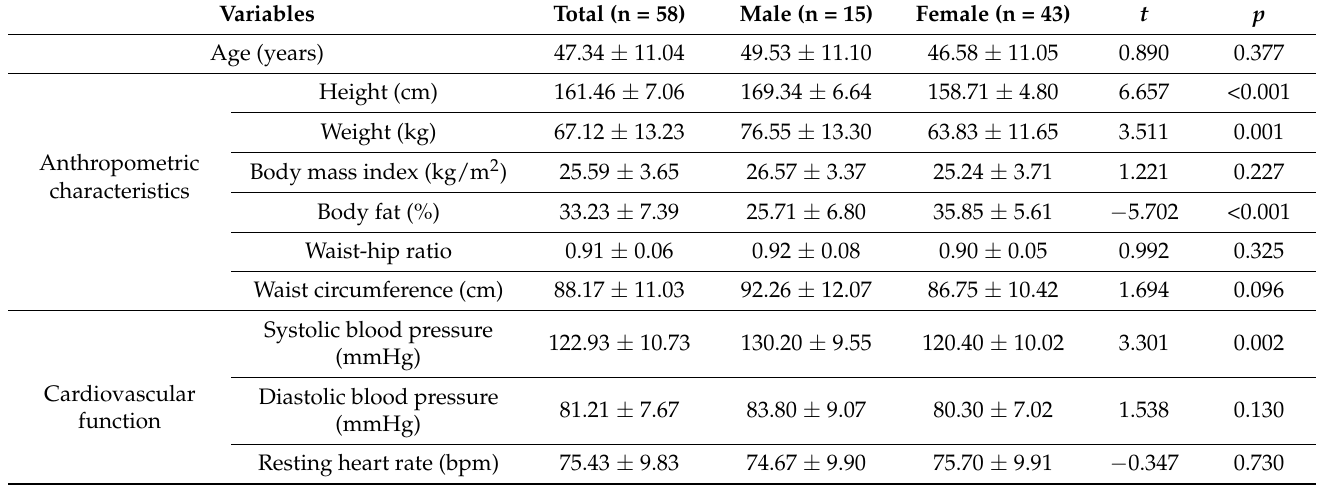
Table 2. General characteristics of the